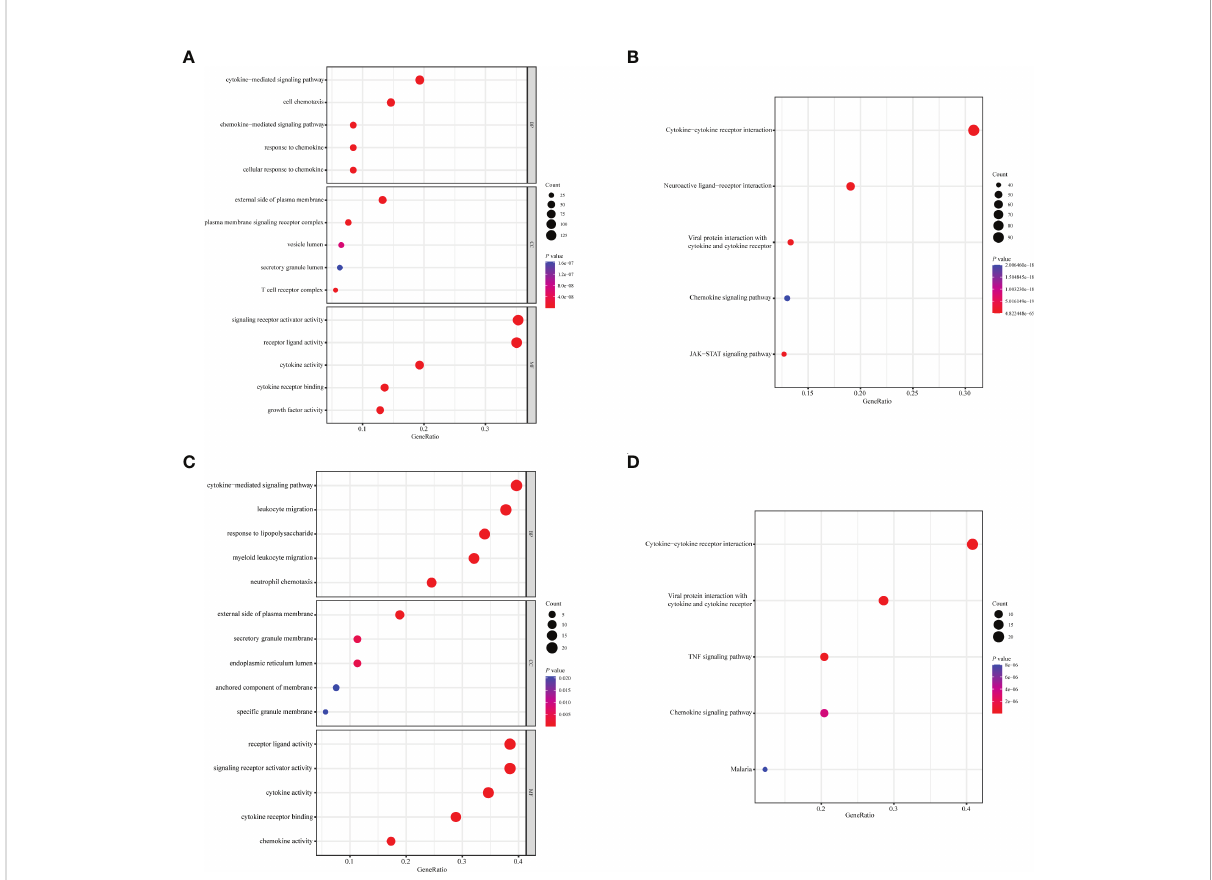
FIGURE 3 Enrichment analysis of immune- orin fl ammation-related differentially expressed genes in the TCGA-BRCA trainingcohort. Bubbleplot of (A) GOand (B) KEGG pathway analysis of immune-related DEGs. Bubbleplot of (C) GOand (D) KEGG pathway analysis of in fl ammation-related DEGs. Each graph showed the top fi ve enriched pathways ofBP, CC, MF, and KEGG.GO, Gene Ontology; KEGG,Kyoto Encyclopedia ofGenes andGenomes; DEGs, differentially expressed genes; BP,biological process; CC, cellularcomponents;MF, molecular function. Gene ratio: the ratioof enriched genes to the total number of genesin the relative pathway inthe correspondingdatabase.Count: the number of enriched DEGs in